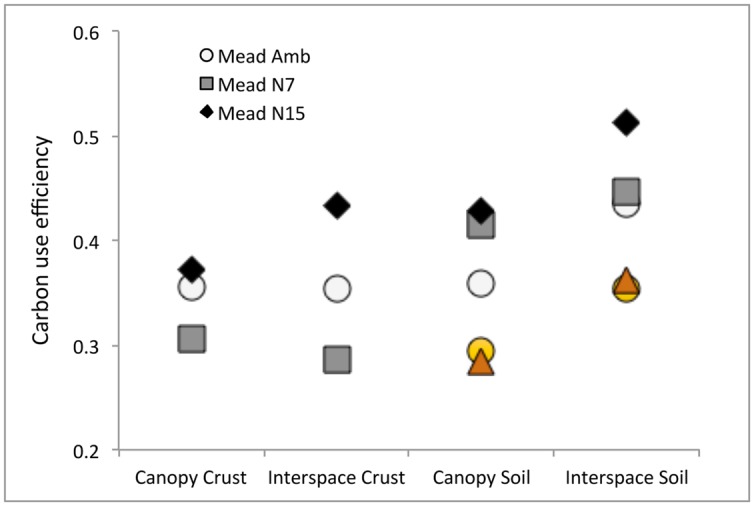
Microbial carbon use efficiency (CUE) by horizon, location, and N treatment. For comparison, the orange circles (Ambient) and triangles (N addition, 10 kg ha-1 y-1) are values calculated for a N addition study conducted in semiarid grassland in New Mexico (Stursova et al., 2006).